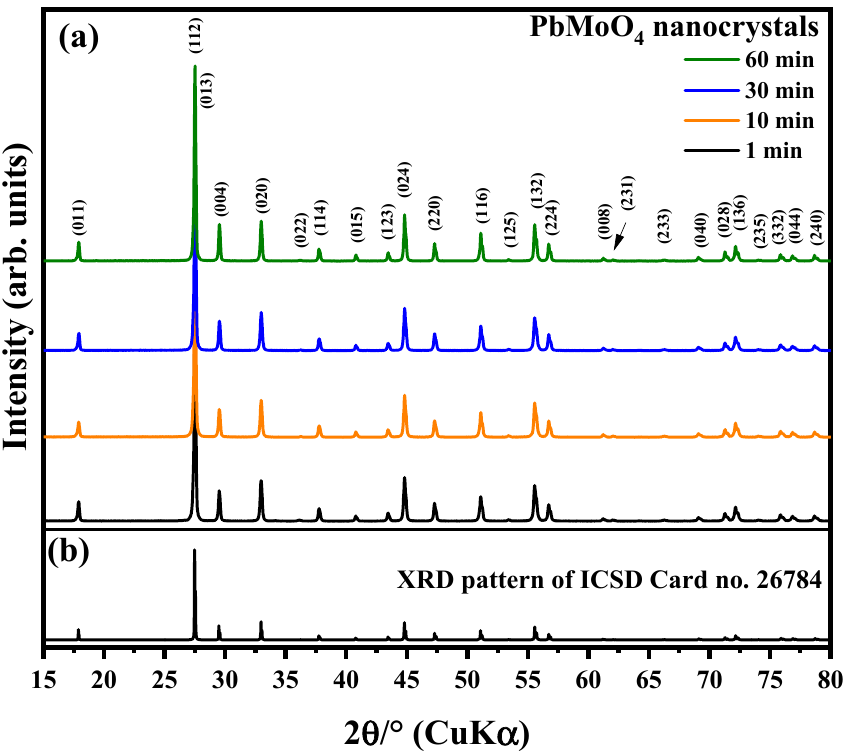
Figure 1. XRD pattern of ( a ) PbMoO 4 obtained from MH synthesis and ( b ) ICSD card no. 26784. The vertical lines indicate the Bragg peak position.